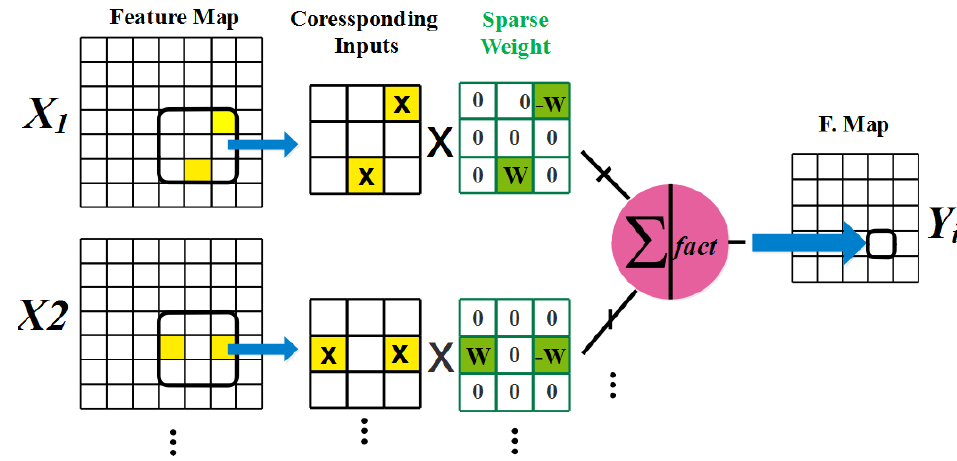
Figure 6. Example of sparse convolution operation.